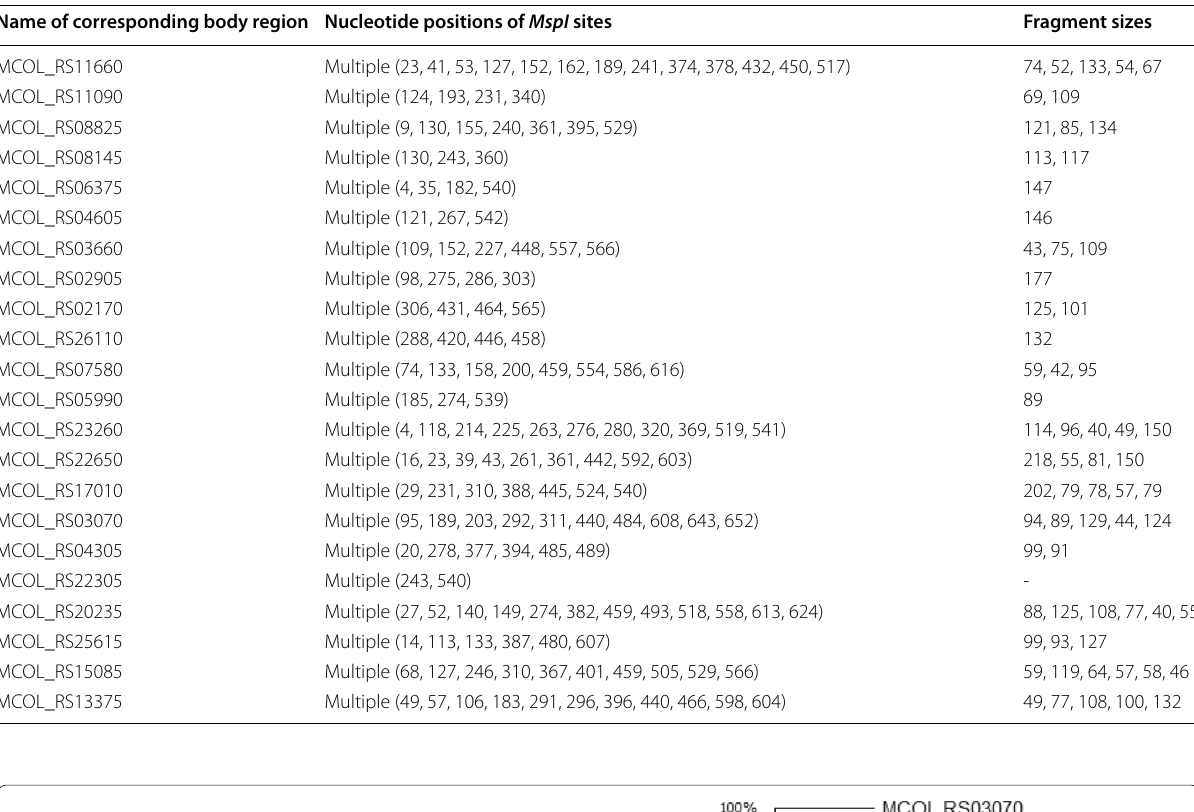
Table 5 MspI cutting sites and fragment sizes for gene body regions Name of corresponding body region Nucleotide positions of MspI sites Fragment sizes